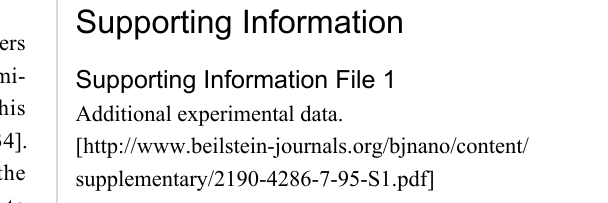
sample, and N ads and N bulk are the number of molecules adsorbed on the SERS substrate and bulk molecules excited by the laser, respectively. Using the 1587 cm − 1 band, the EF values for the SSS, SBS, BSB and BBB thin films are calculated to be about 5.9 × 10 4 , 5.4 × 10 4 , 5.0 × 10 4 and 3.6 × 10 4 ,